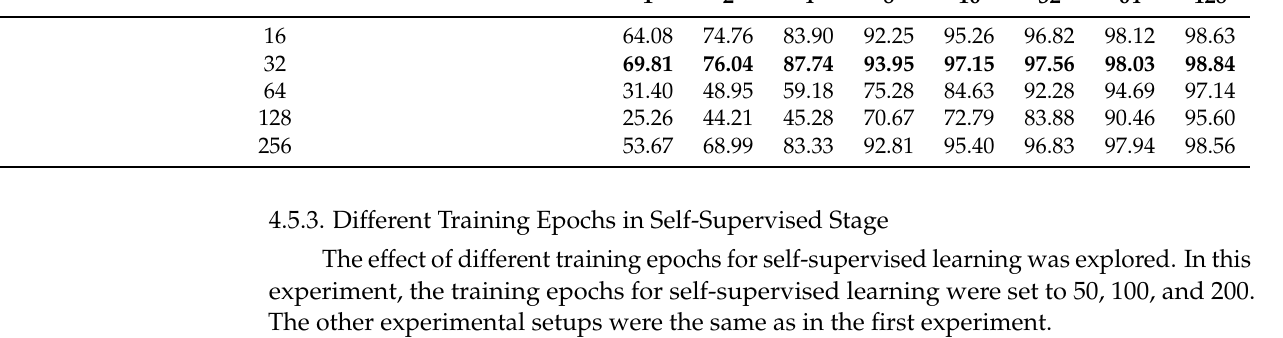
Table 6. The test accuracy (%) of the MsvNetLite with different batch sizes in the self-supervised stage. The bold number is the best result in each column. The bold number is the best result in each column. Number of Labeled Data per Class for Batch Size in Self-Supervised Stage